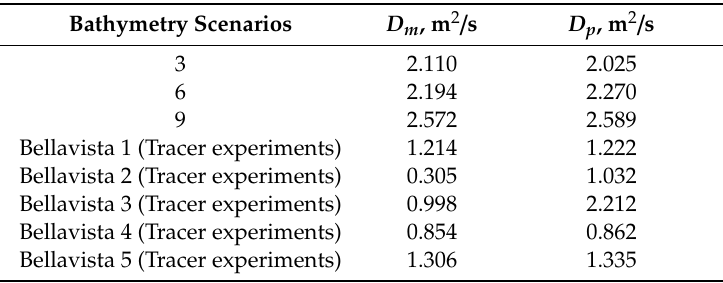
Table 6. Longitudinal dispersion coe ffi cients. D m are the coe ffi cients from numerical modeling and field experiments, D p are the coe ffi cients predicted by Equation